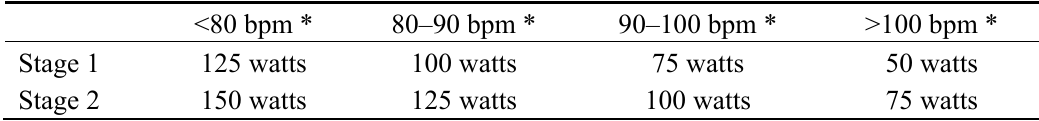
Table 2. YMCA sub-maximal cycling